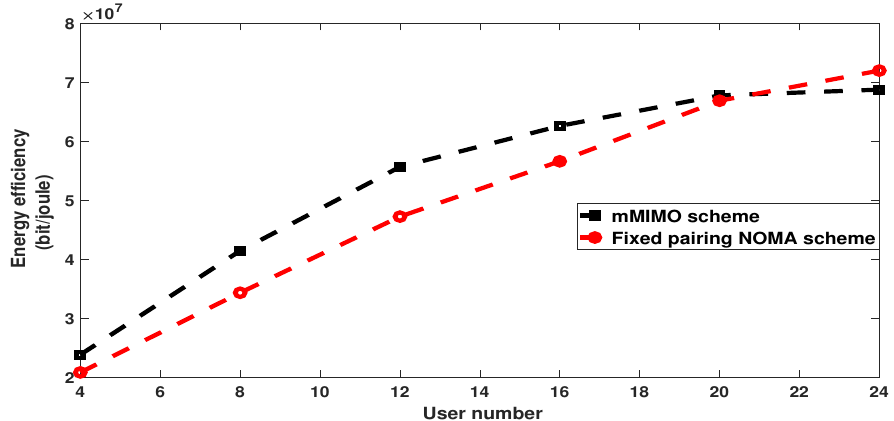
Figure 2. EE for mMIMO-based scheme versus NOMA-based scheme, with A = 36 BS antennas.